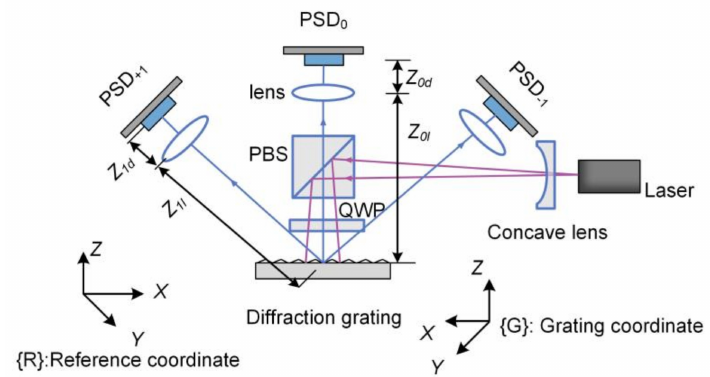
Figure 7. 6-DOF motion measurement system using laser diffraction